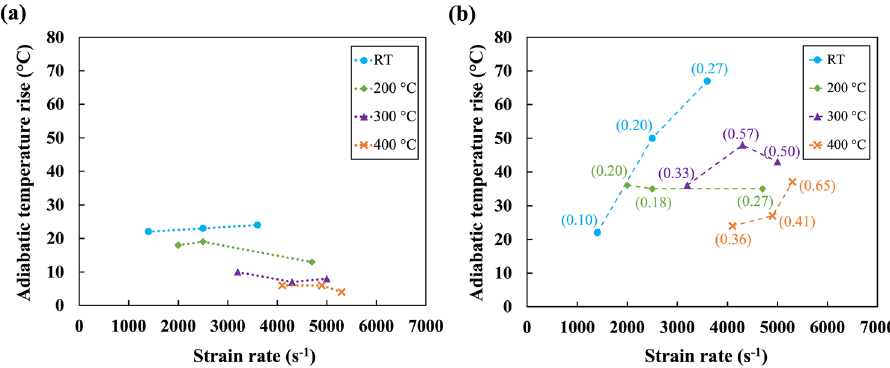
Fig. 14 Estimated adiabatic temperature rise ( a ) up to a true strain of 0.1 and ( b ) due to the maximum strain attained (indicated within parentheses) by the material as a function of strain rate for all deformation